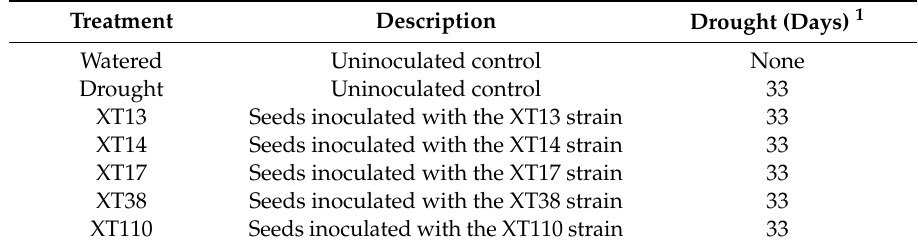
Table 1. Description of the treatments used to evaluate the e ff ect of plant growth-promoting bacteria (PGPB) inoculation on the response of maize to drought